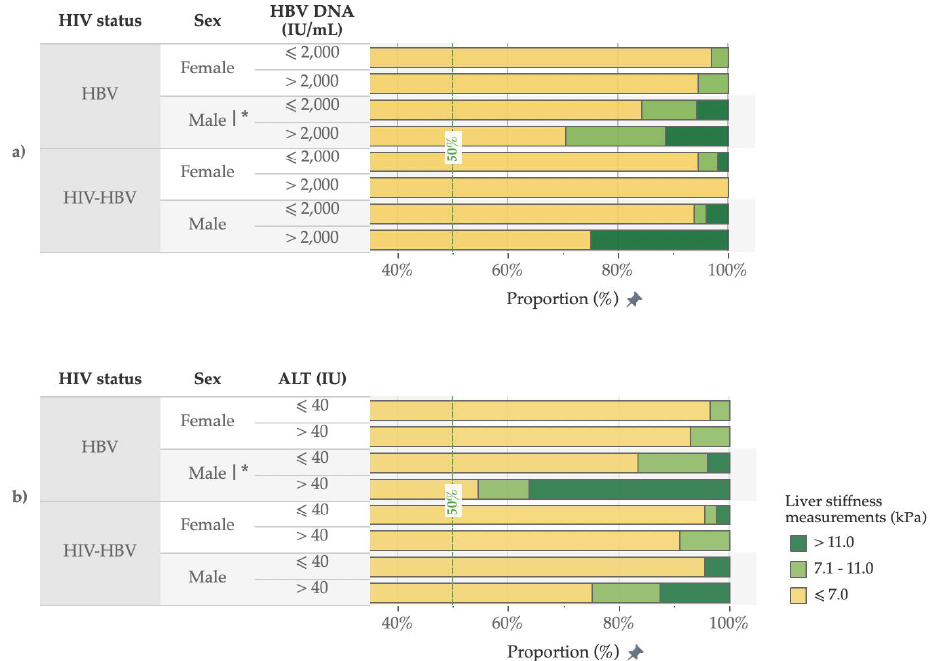
Figure 1. Proportion of participants in the different liver stiffness measurement categories, by HIV status, sex, HBV DNA ( a ) and ALT ( b ) values. |* p < 0.05 in univariable analyses.